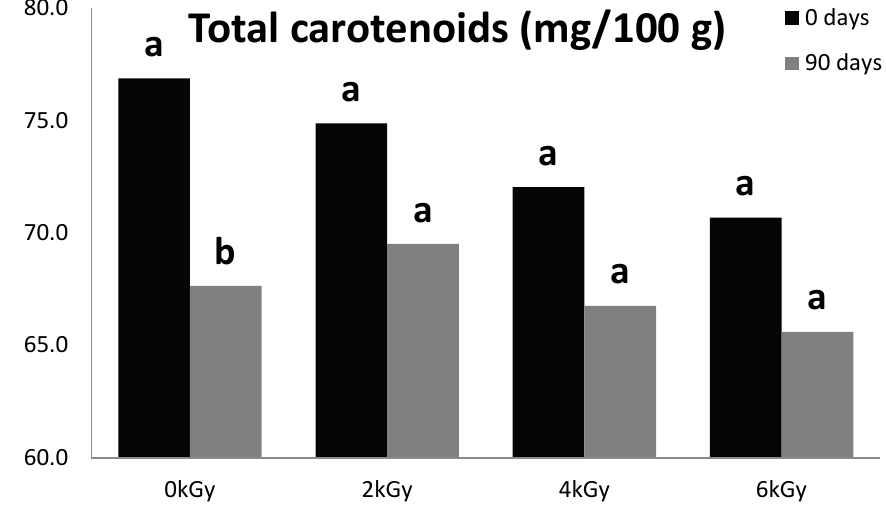
Figure 2. Effect of gamma radiation on total carotenoids concentration in hot peppers during three months’ storage; a , b indicate differences between these pairs of treatment means at p < 0.05.